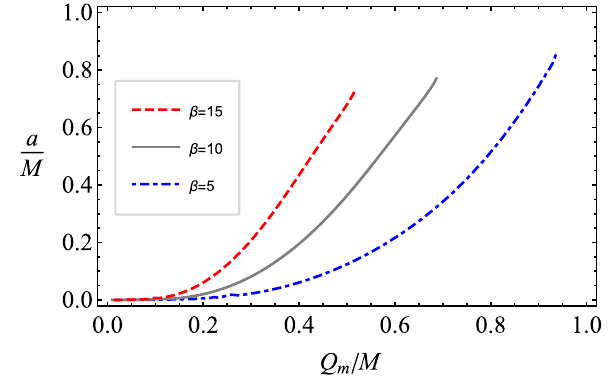
Fig. 6 Relation between degeneracy values of spin parameter of the rotating Kerr black hole and magnetic charge of RN black hole which provides the same values of the ISCO radius for the fixed values of the parameter β = 5 , 10 , 15